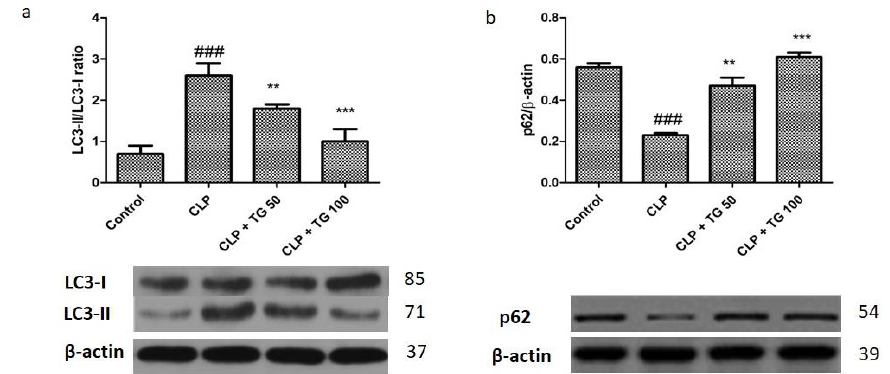
Figure 9. Treatment with TG (50 and 100 mg/kg) inhibits myocardial autophagy. Effect of TG (50 and 100 mg/kg) on autophagy markers LC3 ( a ) and p62 ( b ), along with control protein β-actin. Values represented as means ± SD and n = 12/group. One-way analysis of variance (ANOVA), followed by Tukey’s test were used for statically analysis. Where ### p < 0.001 compared to control group, whereas ** p < 0.01 and *** p < 0.001 compared CLP group animals.